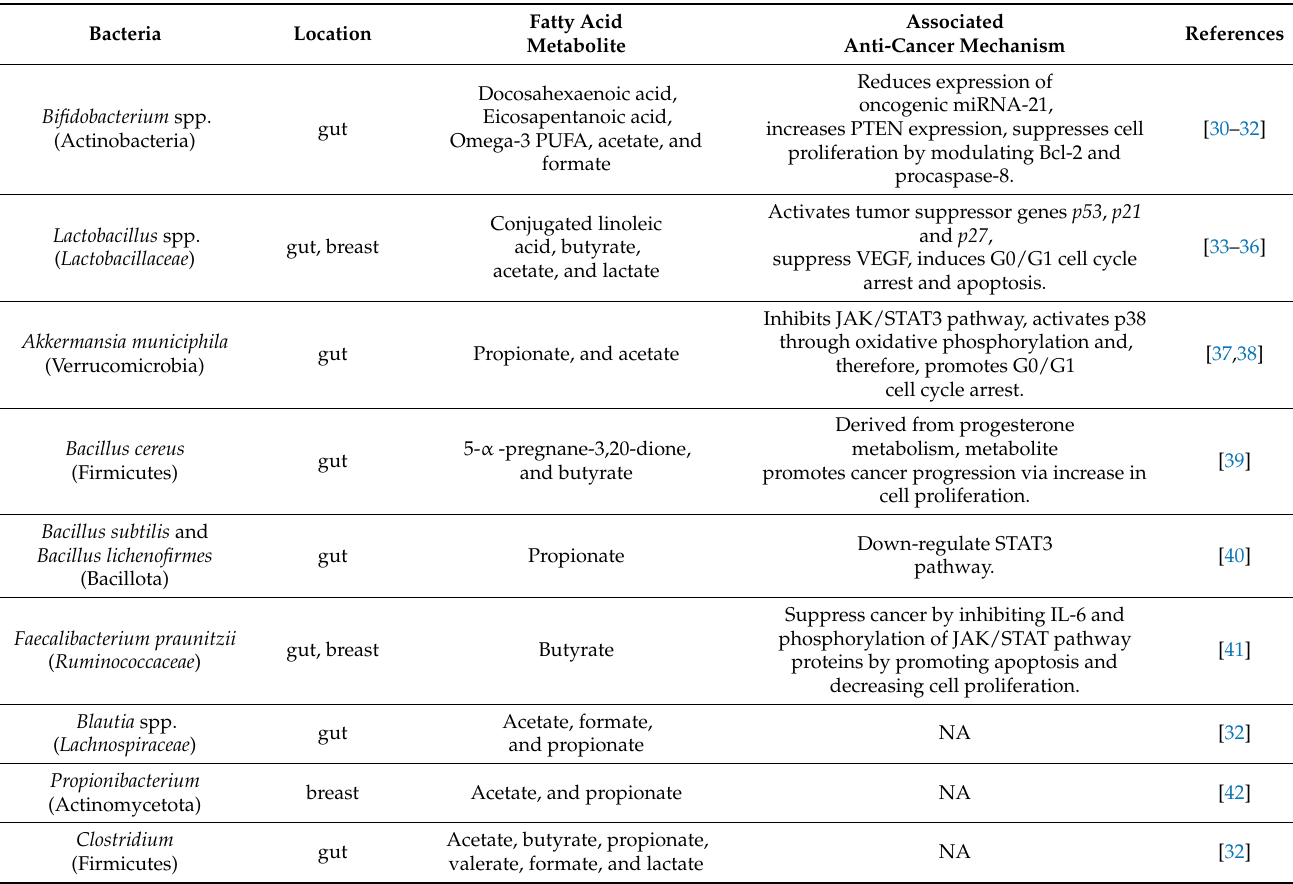
Gut microbiota and breast microbiota produce fatty acid metabolites that have anti-cancer